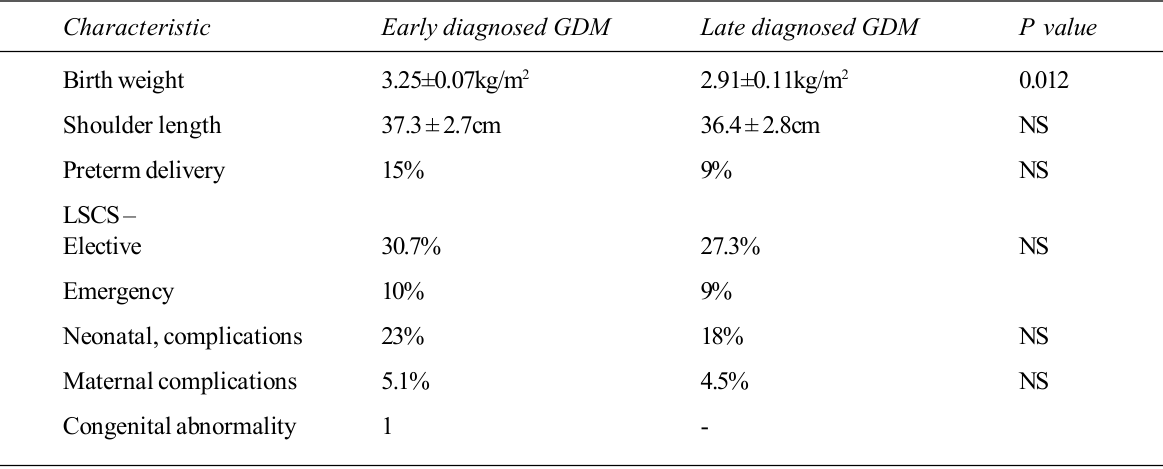
Table 2. Pregnancy outcomes in early and late diagnosis groups among those with gestational diabetes